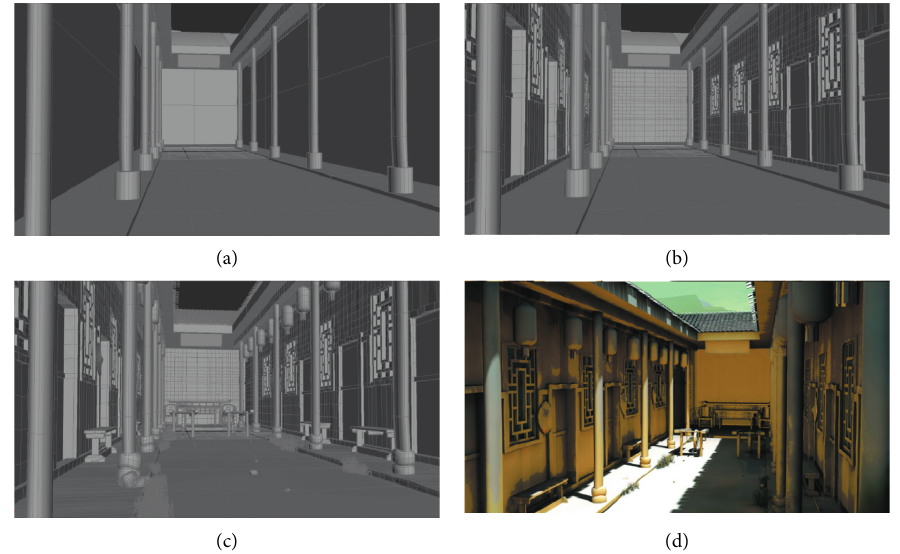
Figure 8: (a) Building for foundational model; (b) building for adjustment model; (c) building for modification model; (d) completed rendered model.